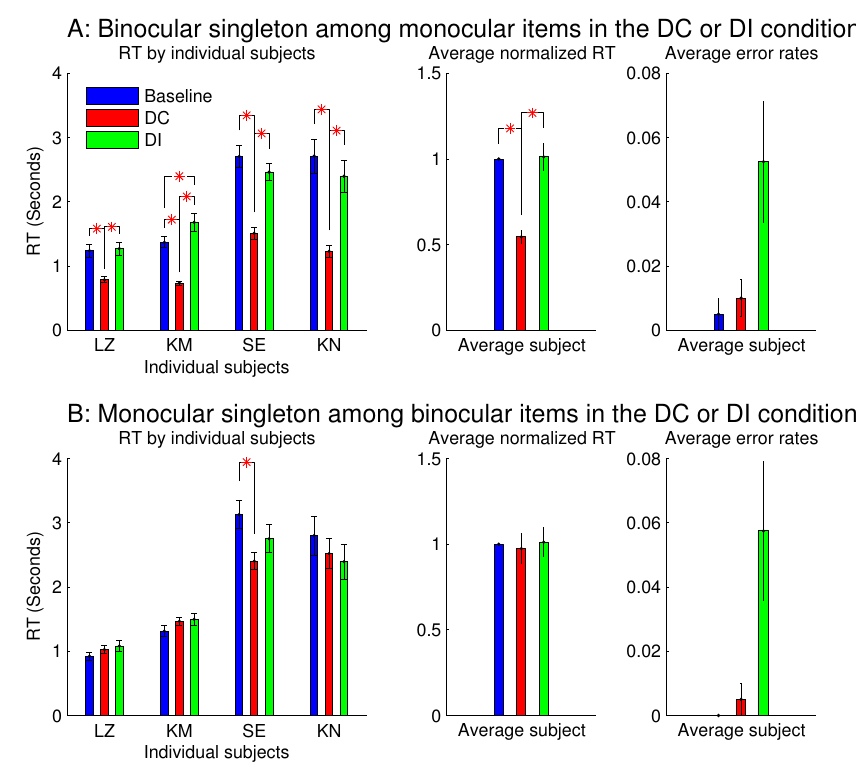
Figure 7. This is like Figure 3, but it contrasts between one ocularity singleton that was a binocular item among monocular items and another that was a monocular item among binocular items. Data for the two figures were collected from separate experimental sessions involving the same task and the same